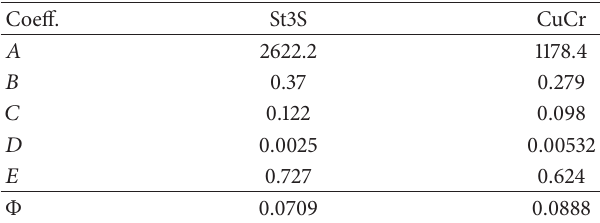
Table 7: Coefficients in (3) determined for St3S and CuCr using inverse analysis with the